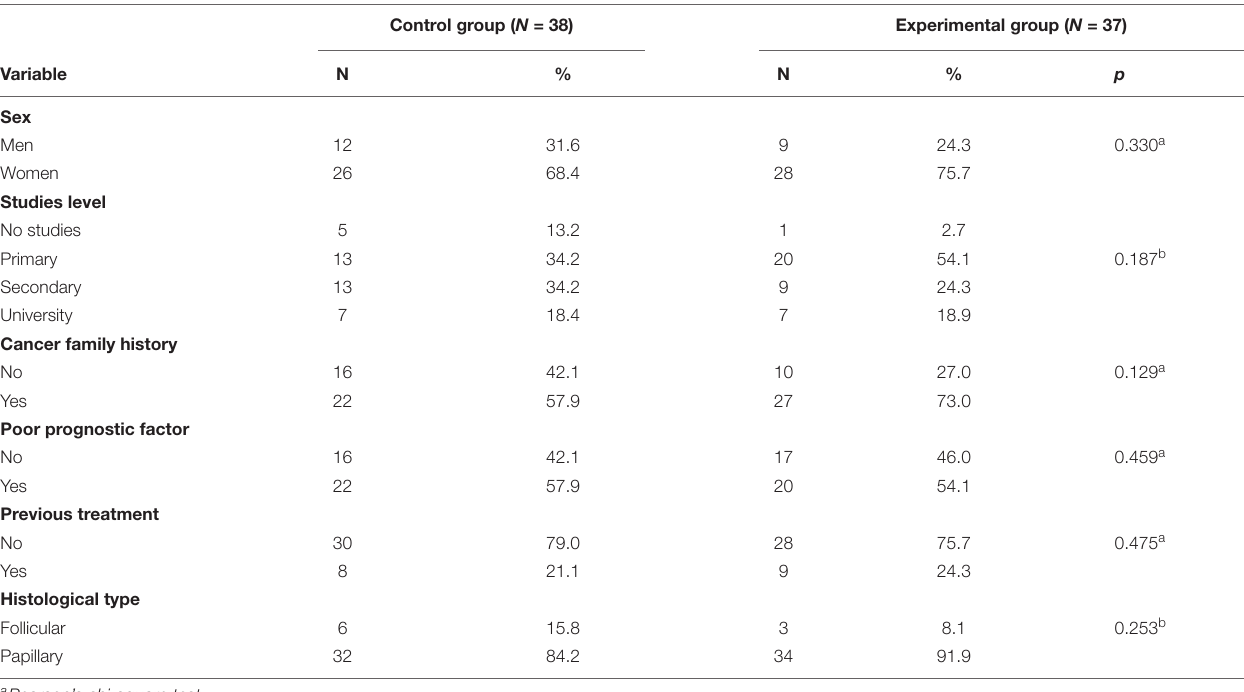
TABLE 2 | Sociodemographic characteristics of patients.